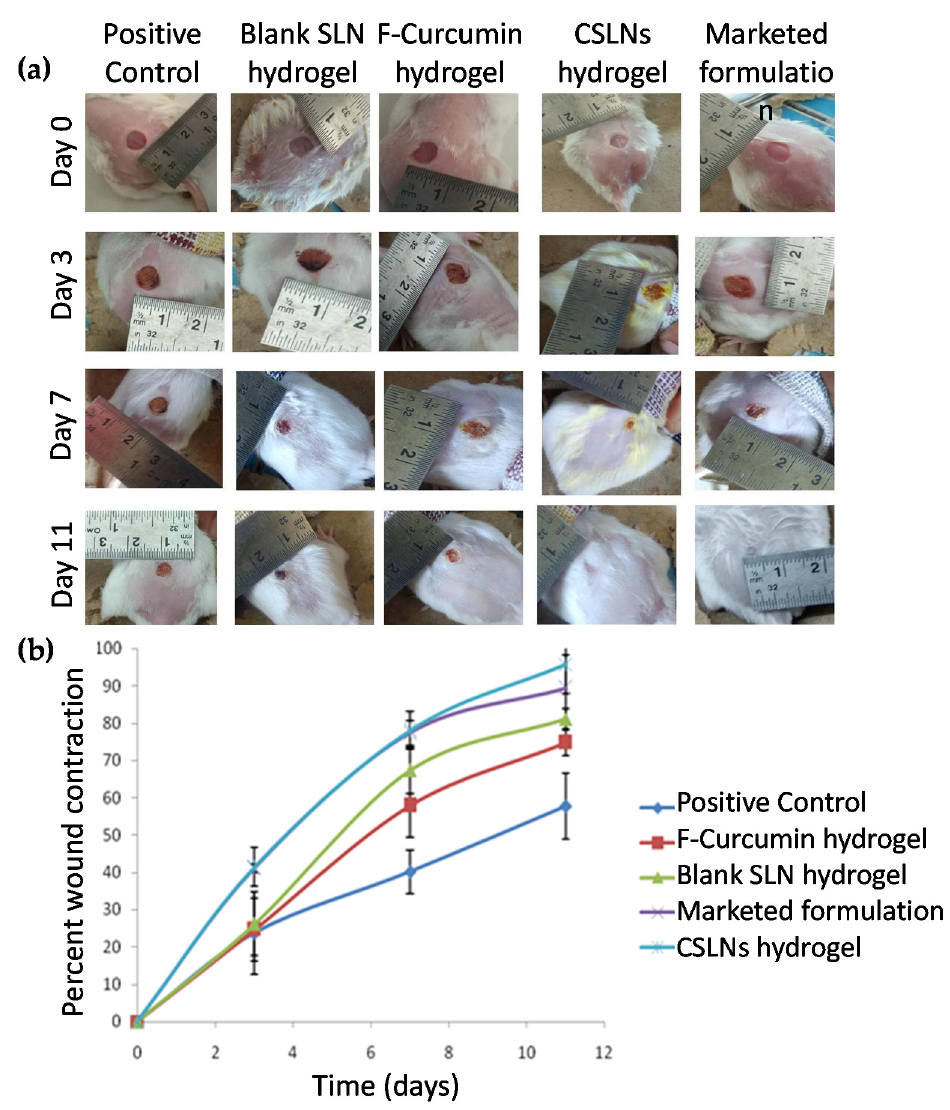
Figure 7. ( a ) Representative wound images taken at day 0, day 3, day 7, and day 11 in different groups, ( b ) percent wound contraction versus days for various treatment groups on different days. F-free.